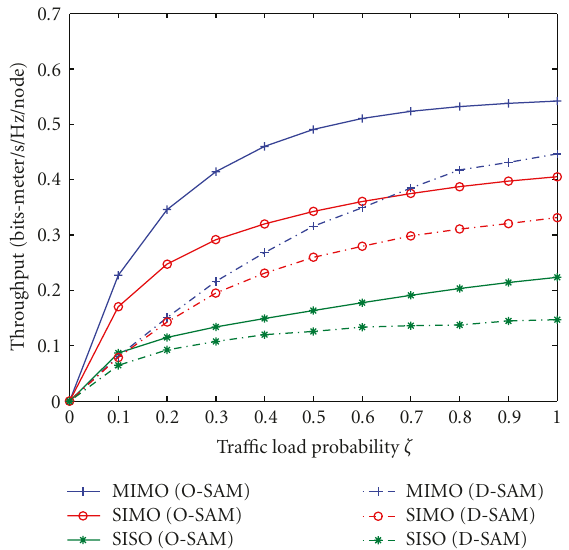
Figure 8: Ratios of throughput: 2-hop range over 1-hop range, and 3-hop rang over 1-hop range. All conditions are the same as for Figure 7.